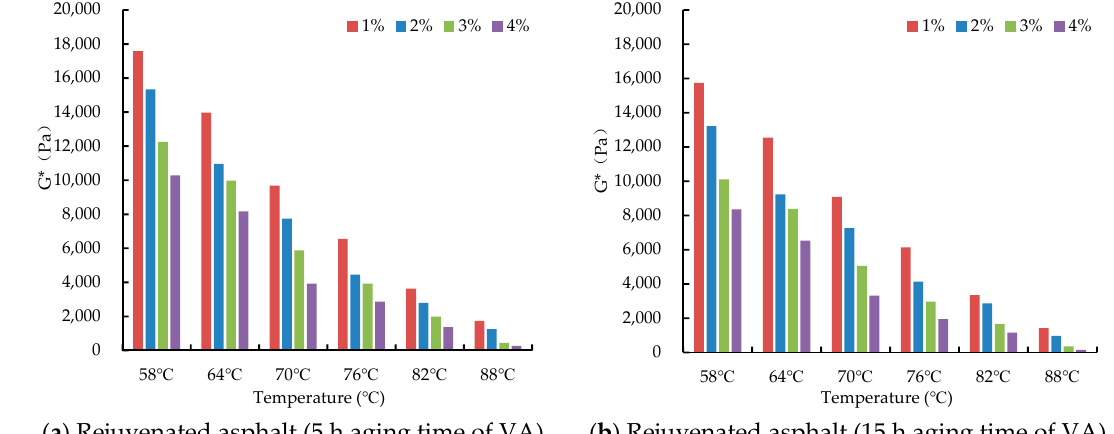
Figure 13. Effects of WEO on complex modulus of rejuvenated asphalt (different aging time of VA).